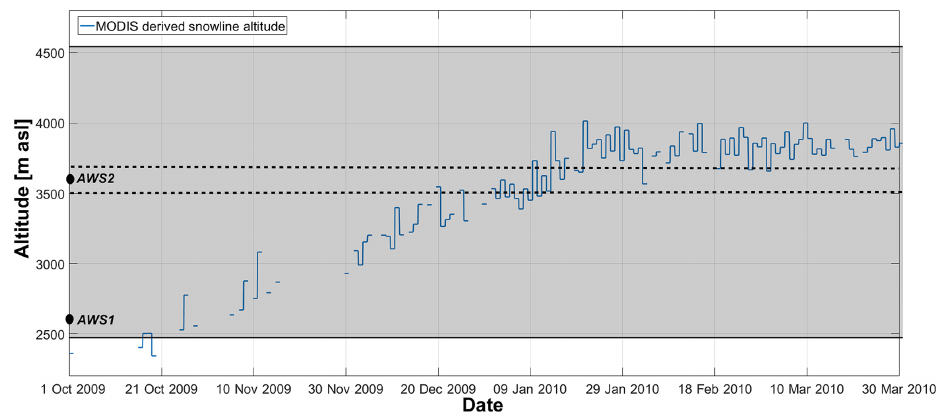
Figure 5. Snowline elevation estimated using the MODIS snow cover product. The grey area corresponds to the altitude range of Universidad Glacier, the dashed line shows the equilibrium line altitude range estimated using an ASTER image of 27 March 2010 and black points show the AWS elevations.